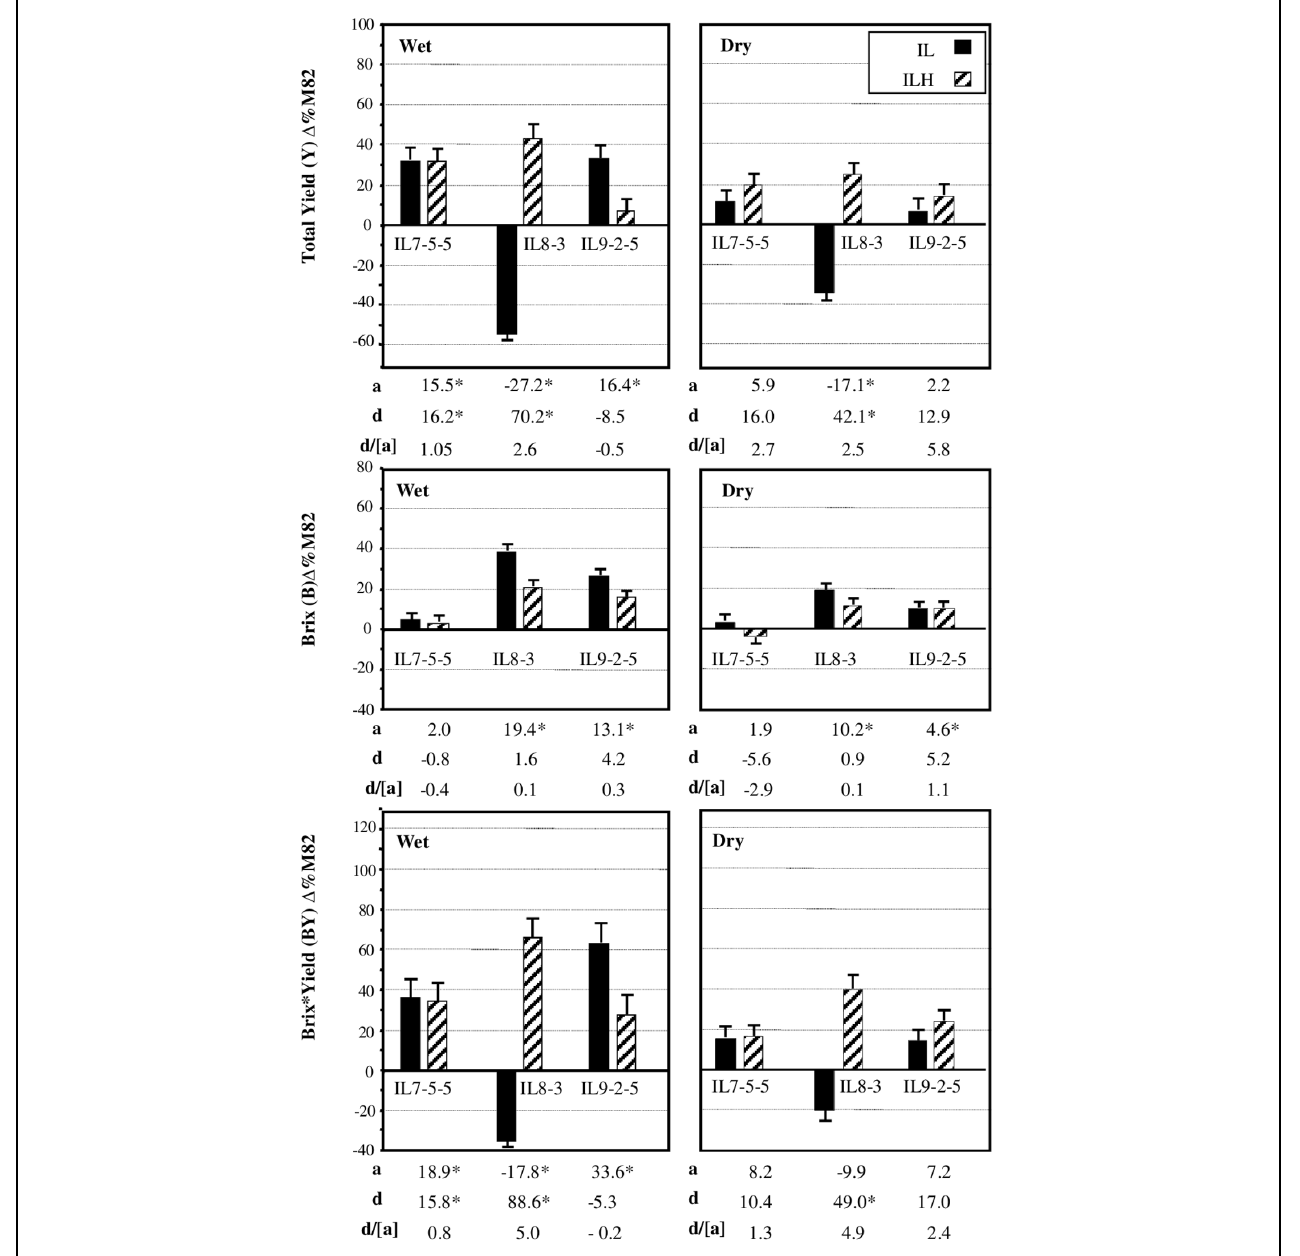
FIGURE 4 | Phenotypic effects of IL 7-5-5, IL8-3 and IL9-2-5 under Dry and Wet field conditions. Introgression lines IL7-5-5, IL8-3, and IL9-2-5 were compared to M82 (data are presented as percent difference from M82) in homozygous (IL) and heterozygous (ILH) states, under Wet and Dry field condition. The bars represent total yield (TY), Brix (BX), and Brix ∗ Yield (BXY) least-square means ( ± standard error) from three growing seasons; these data were pooled, since no season × genotype interactions were found. The baseline represents M82, where the mean BXY values of M82 from the three seasons was 353 g/m 2 in the irrigated treatment and 184 g/m 2 in the dry treatment. The additive effect (a) is half of the difference between each IL and M82. The dominance deviation (d) is the difference between ILH and the mid-value of its parents. Values marked by an asterisk are significant changes from baseline ( p < 0.05). All experiments were transplanted in a randomized block design with 10–15 replications per